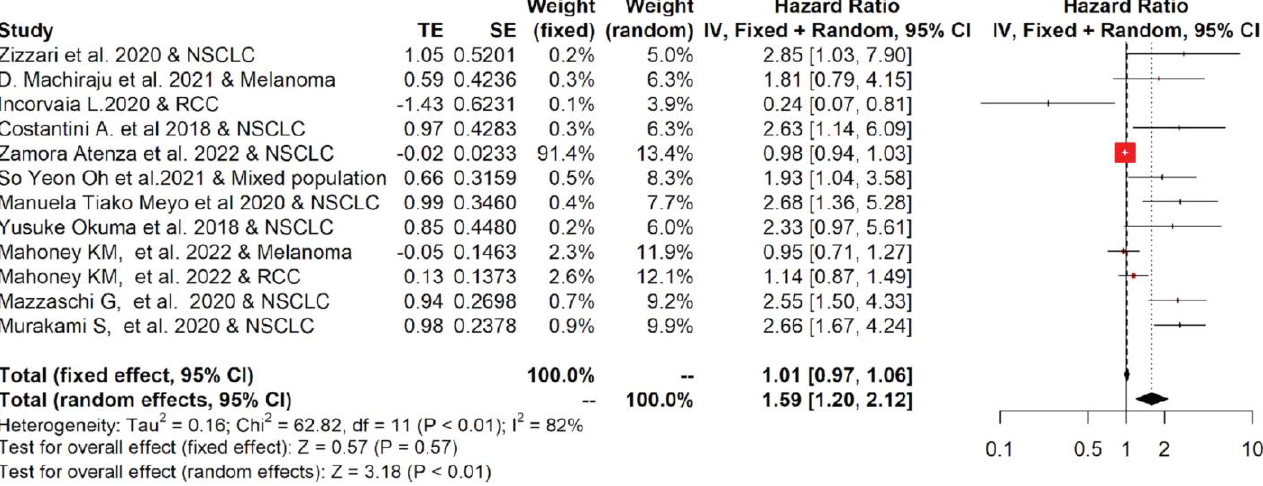
Figure 3. Overall pooled HRs comparing the high- versus the low-PD-L1 values group for PFS in patients with solid cancer treated with immunotherapy. The column study indicates the reference (from which we extracted or calculated the HR and 95% CI) and the investigated tumor type [18–29]. Thus, our analysis indicated that the value of sPD-L1 in the blood can be